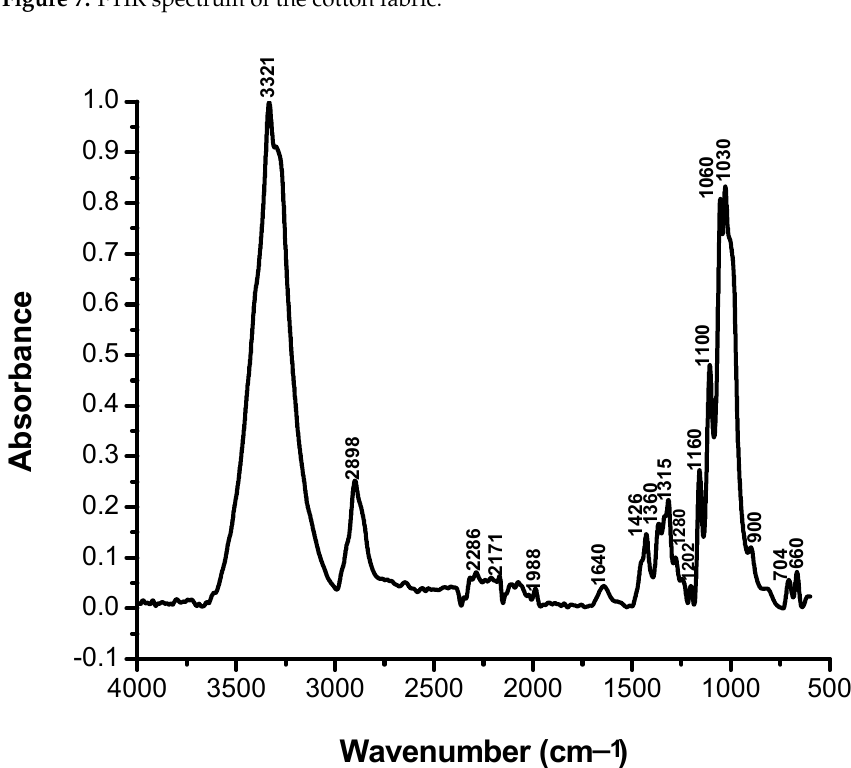
Figure 8. FTIR spectrum of the cotton fabric dyed with RB_204.